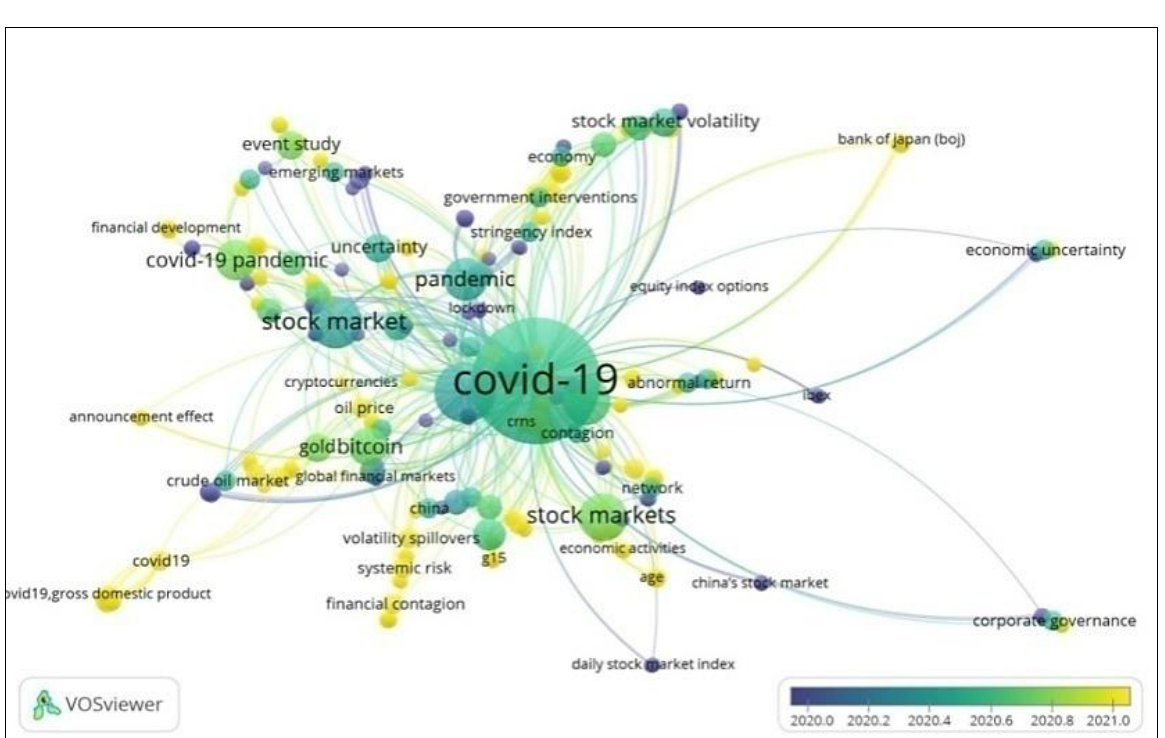
Figure 13. Overlay Visualization